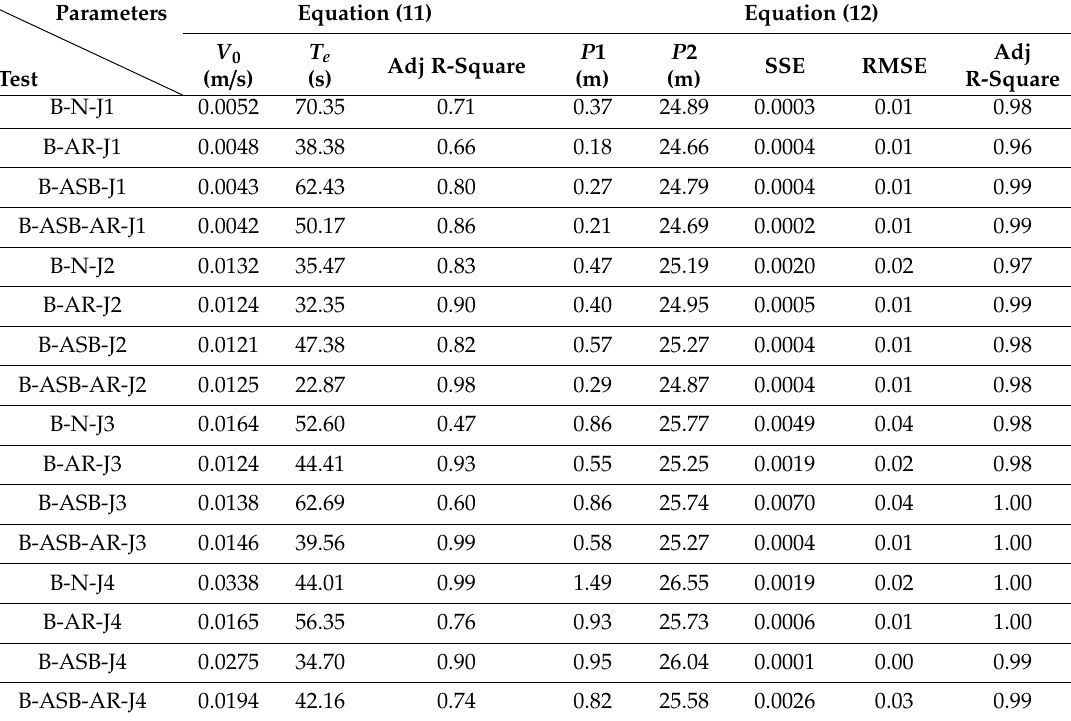
Table 3. Fitting parameters with evaluations of the exponential model on scarp evolution. (SSE: The sum of squares due to error; RMSE: Root mean squared error; Adjusted R-square: Degree-of-freedom adjusted coe ffi cient of